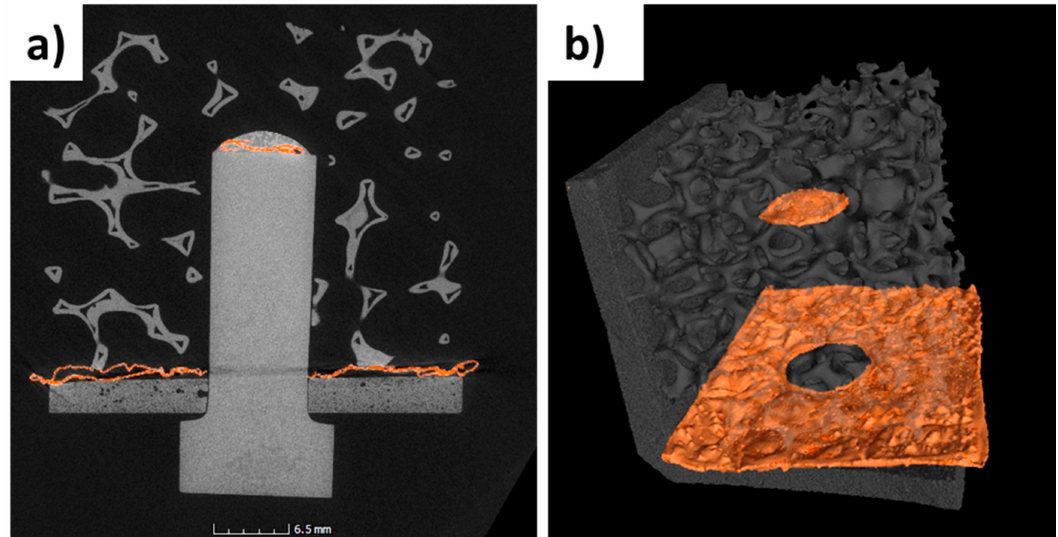
Figure 14. Tomographic reconstruction of the mock-up, showing the pin/substrate area ( a ) and the joining material (orange) at the bottom of the joined components (substrate and foam) and on the top of the pin ( b